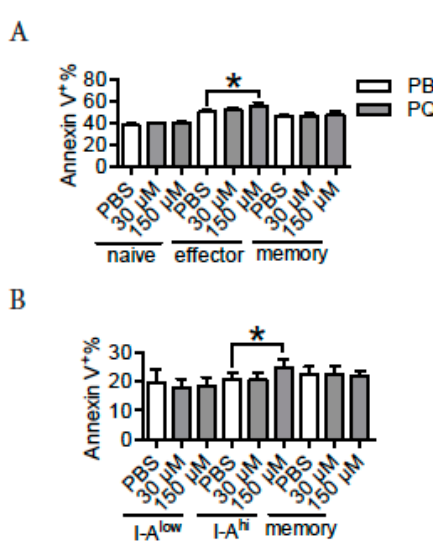
Figure 4. PQ preferentially induced apoptosis in effector lymphocytes relative to naïve or memory lymphocytes. Different subtypes of splenic CD4 T cells (naïve: CD3 + CD4 + CD62L + CD44 − ; effector: CD3 + CD4 + CD62L − CD44 + ; memory: CD3 + CD4 + CD62L + CD44 + ) and B cells (I-A low : CD19 + I-A low CD80 − ;